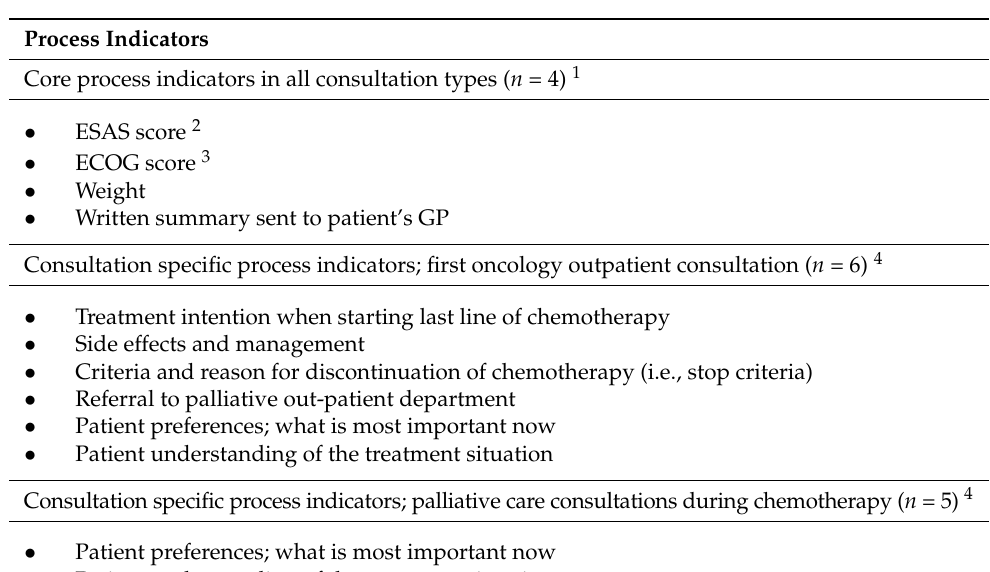
Table 1. Core and consultation specific indicators in the PALLiON pathway